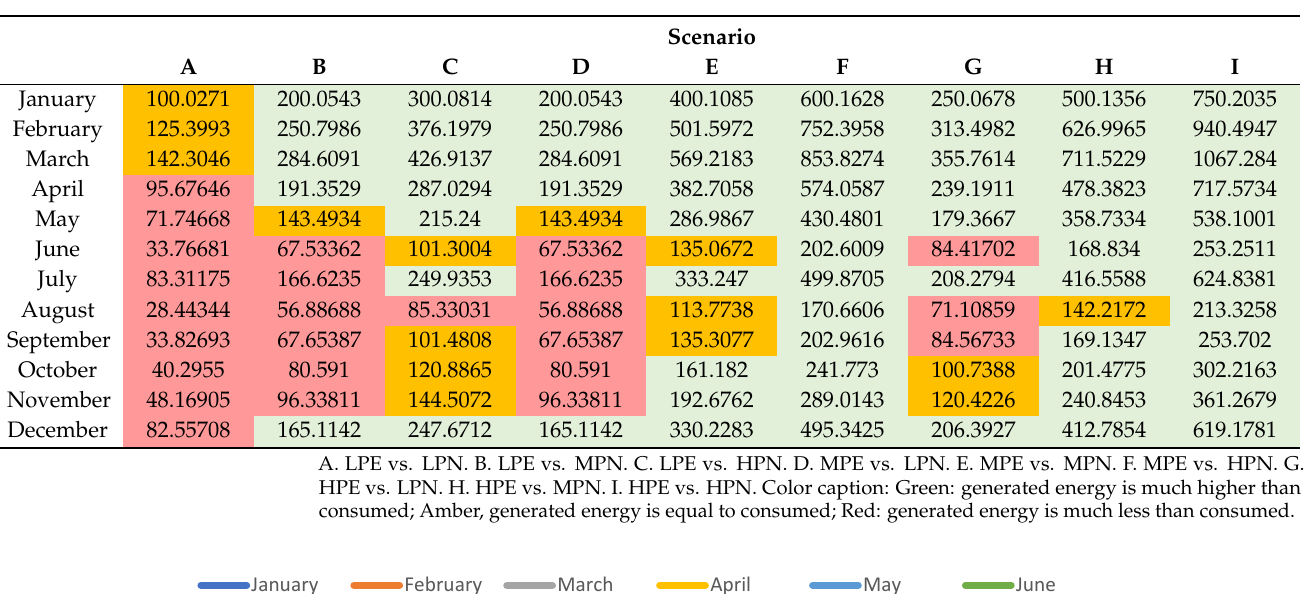
Table 3. GtoC to Compare Different Installation Scenarios.